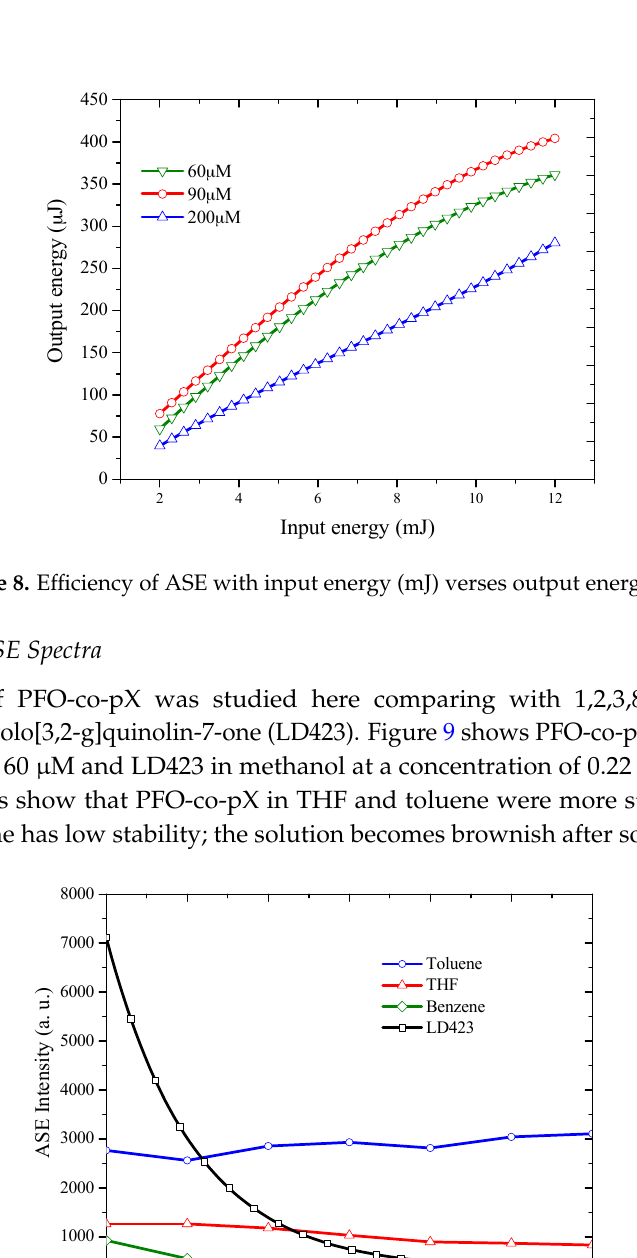
Table 2. Maximum ASE intensity values of conjugated (ADS145UV) polymer in different solvents at 200 μ M, 12 mJ.